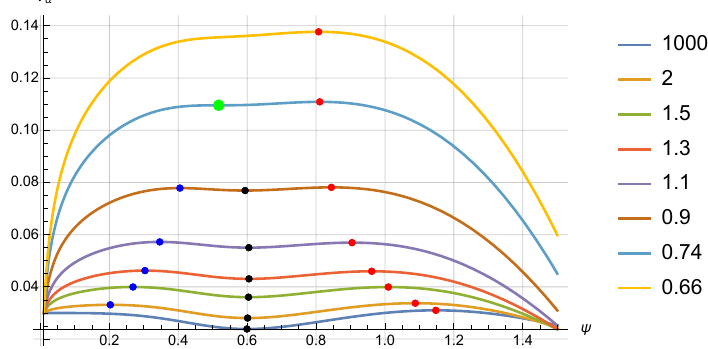
Figure 3 . Plots of the non-extremal potential V as a function of ψ for p/ ˜ M = 0 . 03. The range of α the plot is restricted in the region ψ (0 , 1 . 5) where the most interesting physics occurs. Different ∈ colors depict the potential at different values of the non-extremality parameter α (the specifics of these values are listed in the legend). The blue dots indicate the unstable fat M5 vacua near the north pole ( ψ = 0). The black dots indicate the metastable vacuum. The red dots indicate a second unstable vacuum (thin M5 branch). The green dot at α 0 . 7424 is a merger point of the blue and (cid:30) black vacua.